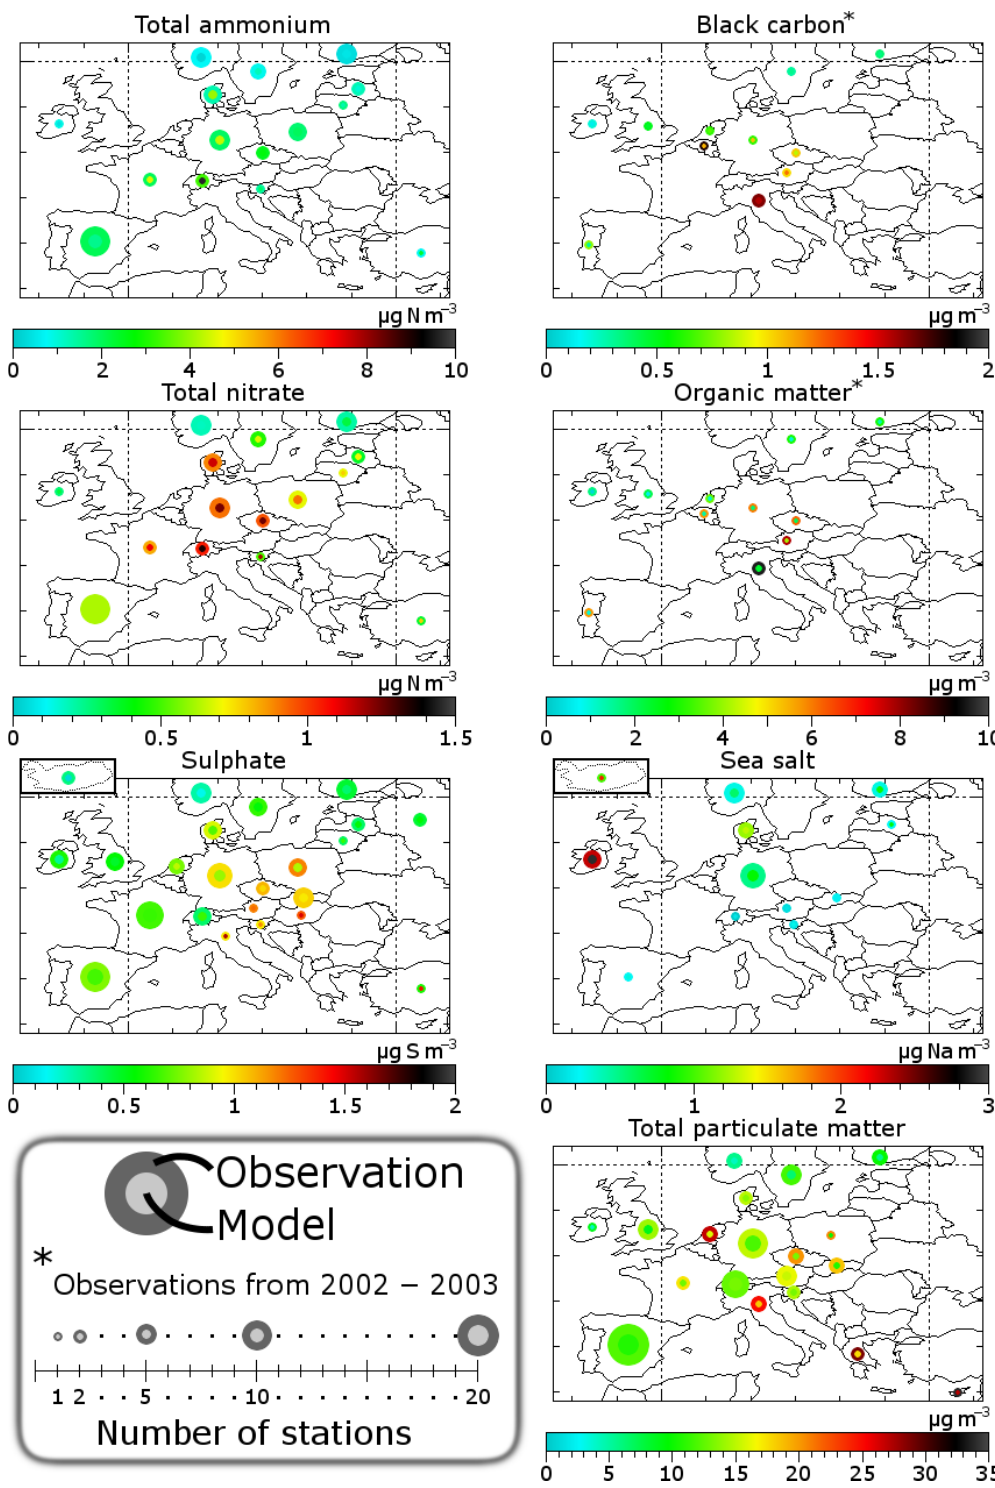
Fig. 4. Graphical overview of the comparison between modelled and observed average concentrations over 2006 for total ammonium, total nitrate, sulphate, black carbon, organic matter, sea salt and total particulate matter at EMEP ground stations. Values of stations per country are averaged. The size of the circles represent the number of stations in that country. The country in the upper left box of the sulphate and sea salt maps, is